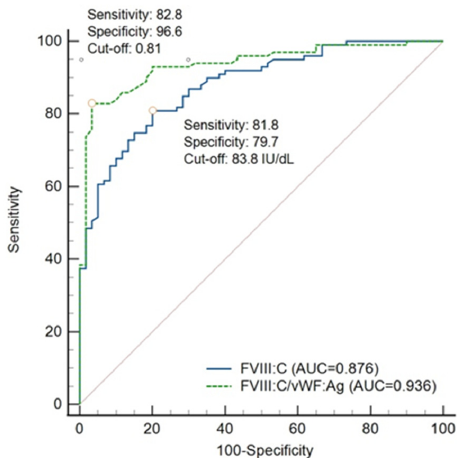
Figure 2. Receiver operating characteristics analysis of FVIII:C/VWF:Ag ratio and FVIII:C. Abbrevia- tions: AUC, area under curve.